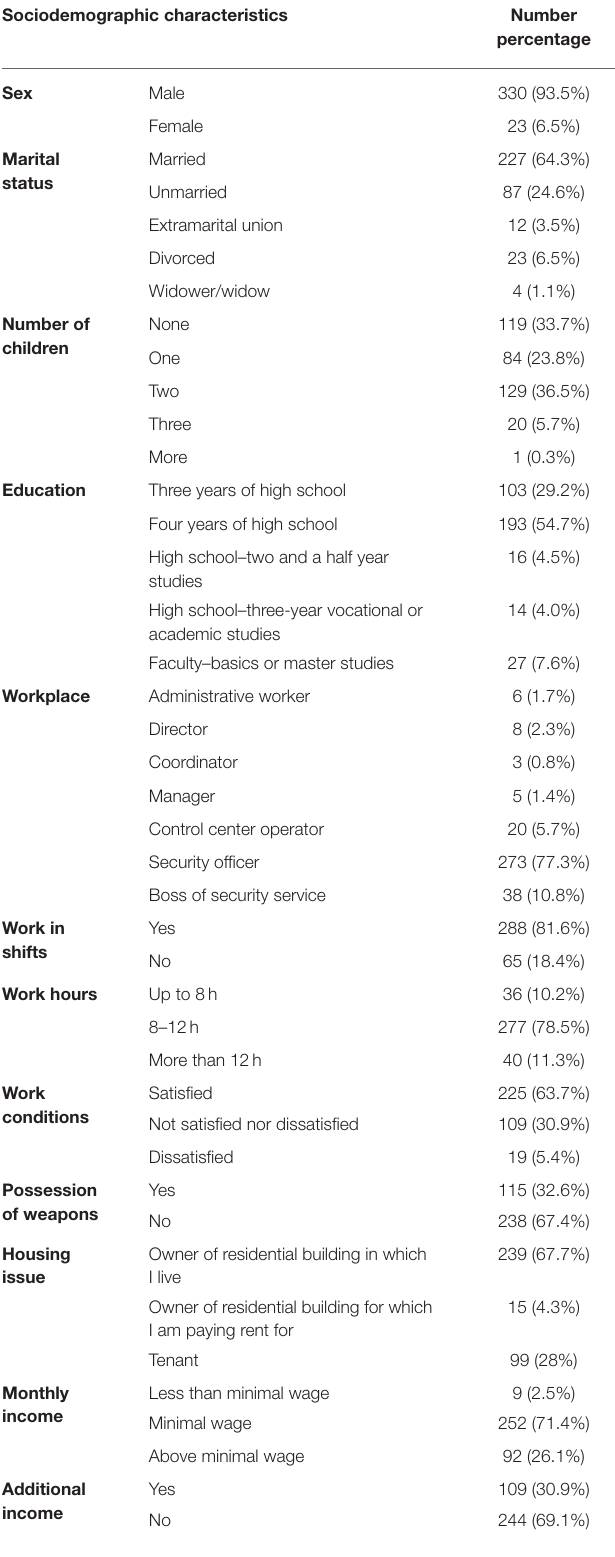
TABLE 2 | Basic socio-demographic characteristics and the length of service in regard to the sex distribution of the respondents. Sociodemographic